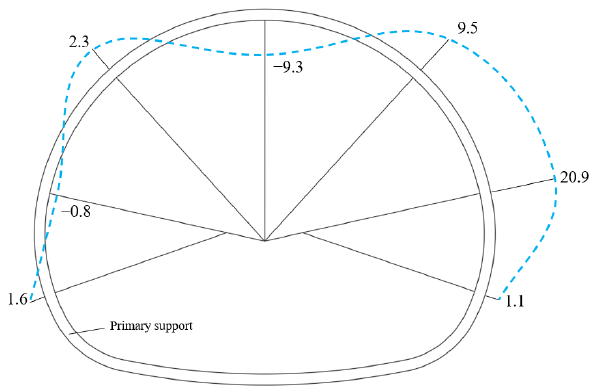
Figure 28. Stress distribution diagram of spray concrete (Unit: MPa).